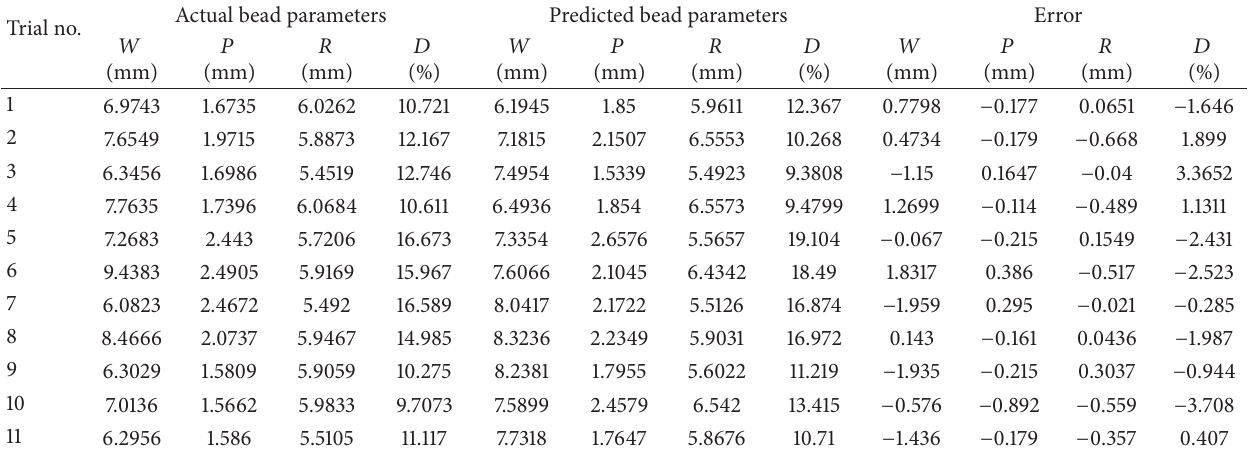
Table 6: Comparison of actual and predicted values of the clad bead parameters using neural network data (test). Trial no.